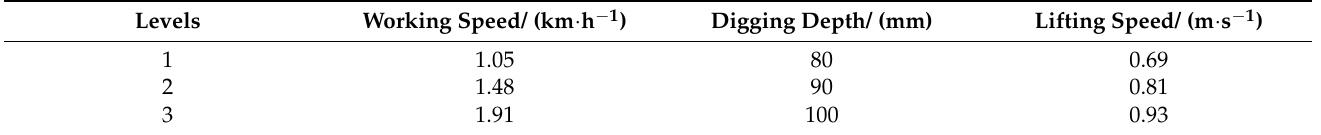
Table 3. Factors and levels of orthogonal experiment.